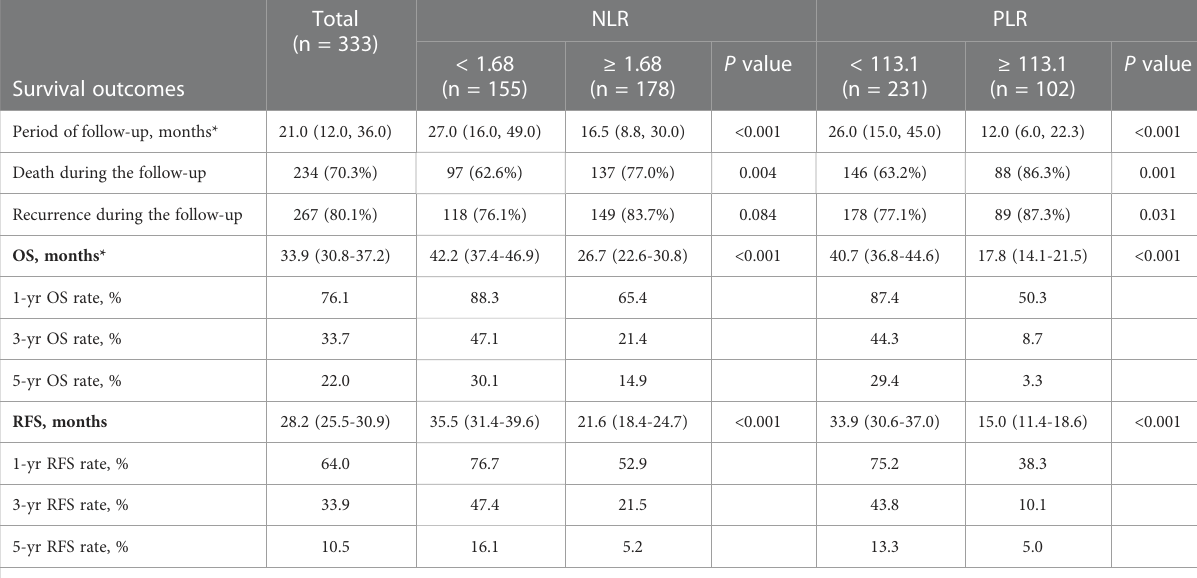
TABLE 2 Comparisons of survival outcomes between pCCA patients with high and low NLRs and PLRs.